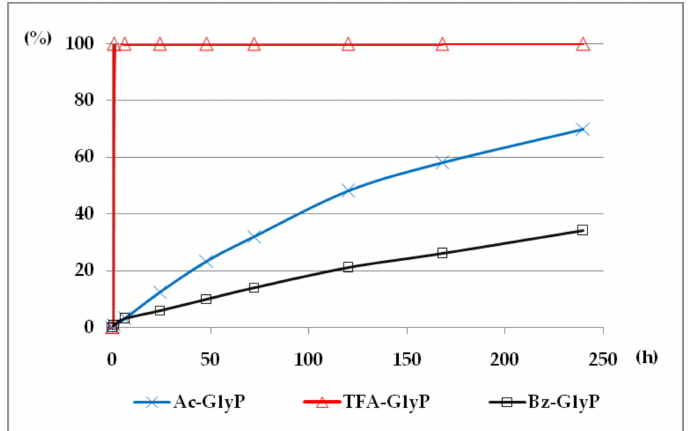
Figure 7. A solution of 0.1 M 1-(acylamino)methylphosphonic acids (AC)-Gly P (AC: Ac, TFA, Bz) in 2M KOH reacted at 25 ◦ C, which was monitored by 31 P NMR [DD (%) vs. time (h)]. Points on the plots corresponds to Gly P released from the parent (AC)-Gly P , which means Gly P from Ac-Gly P , Gly P from Bz-Gly P and Gly P from TFA-Gly P .